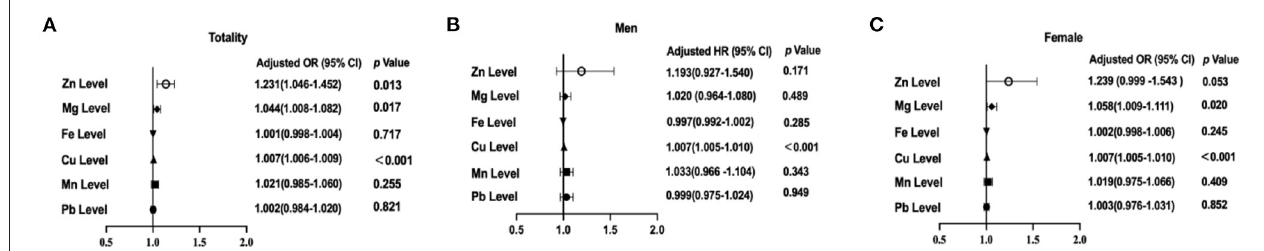
FIGURE 3 | Associations of selected trace elements levels with the prevalence of thyroid nodules (TNs) among the participants. (A) Selected trace elements levels and the prevalence of TN in total participants; (B) Selected trace elements levels and the prevalence of TNs in males; (C) Selected trace elements levels and the prevalence of TNs in females. In the total population, the model was adjusted for model 2. In stratified analysis by sex, the model was adjusted for age, UIE, BMI, smoking status, excessive alcohol consumption, HbA1c, TC, TG, and